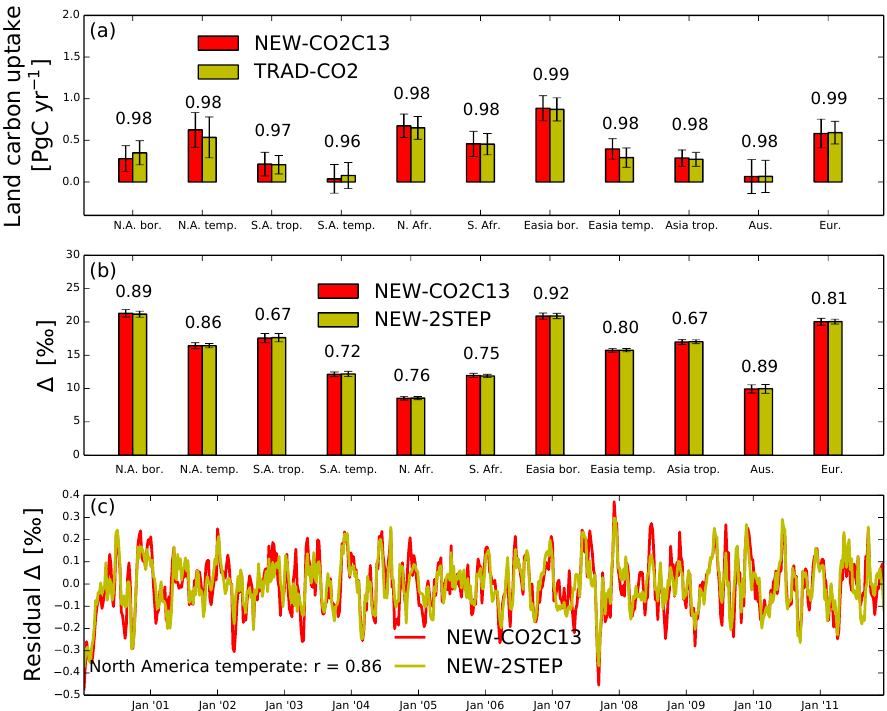
Figure 9. (a) the 11 year mean land carbon uptake (PgCyr − 1 ) for each TransCom region with estimates from the nonlinear NEW − CO2C13 inversion (red) and estimates from the linear TRAD − CO2 inversion (yellow). Error bars depict 1 σ SD of the flux IAV. The 11 year corre- lation coefficients r between the two inversion methods are given on top of the bars. These correlations are based on the 3 month boxcar mean anomalies after subtracting the seasonal cycle. (b) Comparison of (cid:49) ph (‰) between the NEW − CO2C13 inversion and the linear NEW − 2STEP inversion. We again provide IAV error bars and correlation coefficients between inversion methods. (c) The 3 month boxcar mean anomalies in (cid:49) ph for the North America temperate TransCom region to illustrate the high degree of similarity between both inversion methods ( r = 0 . 86).